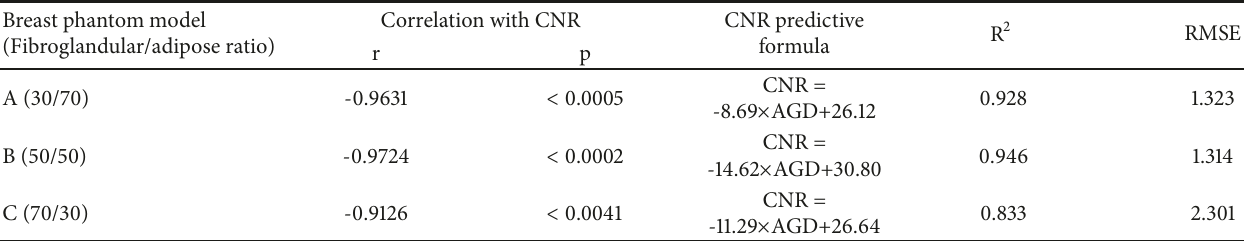
Table 5: Predictive formulae for CNR according to breast density.